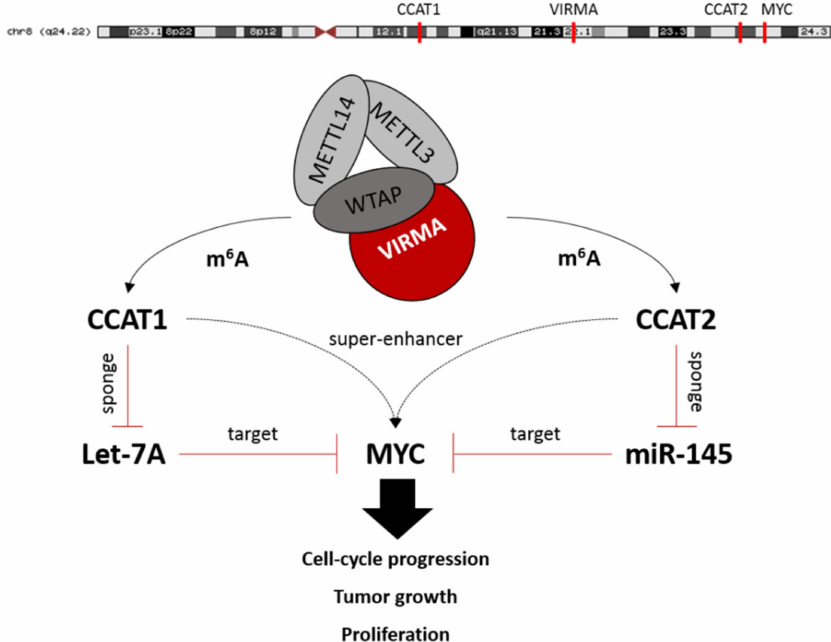
Figure 8. Proposed mechanism of the interplay between the putative VIRMA-dependent m 6 A-regulated CCAT1 / 2 lncRNAs and MYC